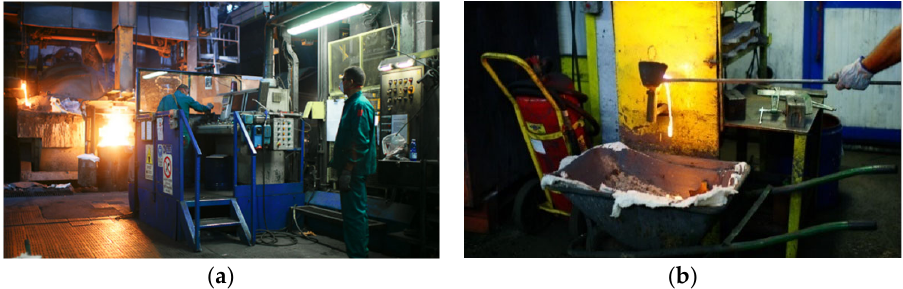
Figure 1. Foundry during the production phases: ( a ) the cast iron descends from the cupola furnace (not visible) through the sprues to the secondary furnace, and then into the ladle (in the foreground); ( b ) chemical composition tests conducted by measuring the cooling curves (performed by an operator taking the melt directly from the ladle and pouring it into the instrument).